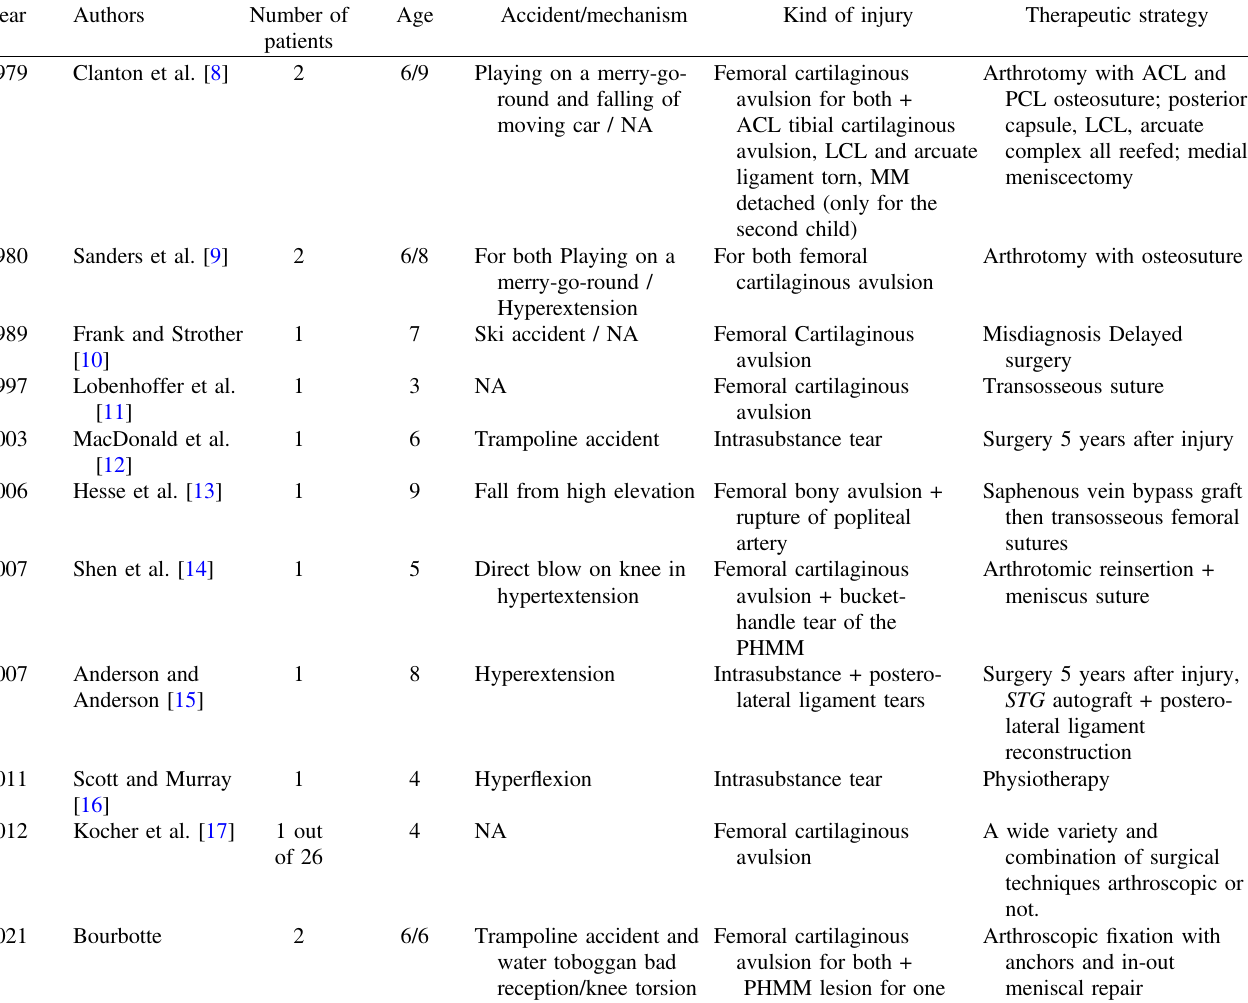
Table 1. Recent literature review of cases reported PCL injuries in children under the age of nine.